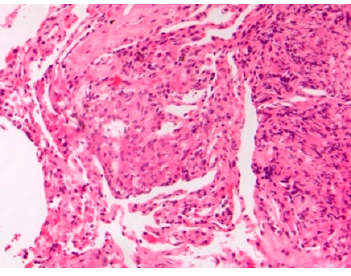
Figure 5. Lung sarcoidosis young E-cig vaper. H&E. Magnification 200×.